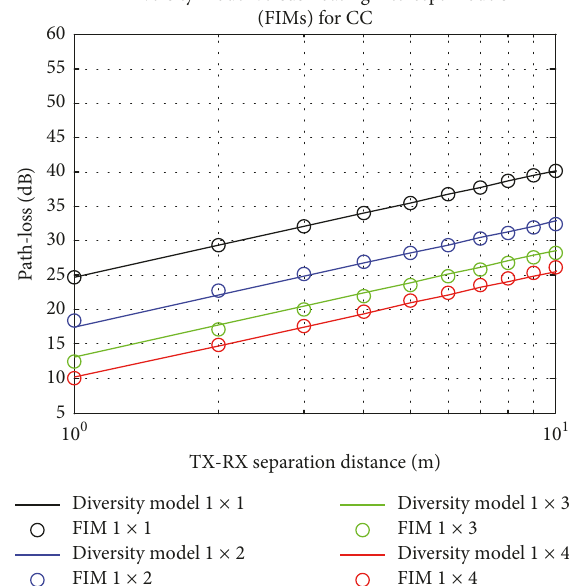
Figure 16: Path-loss for the proposed floating intercept-based diversity model given by (6) for the CC scheme when considering LOS scenario, with 𝛼 SISO = 24.75 , 𝛽 SISO = 1.54 , and 𝐵 = 0.295